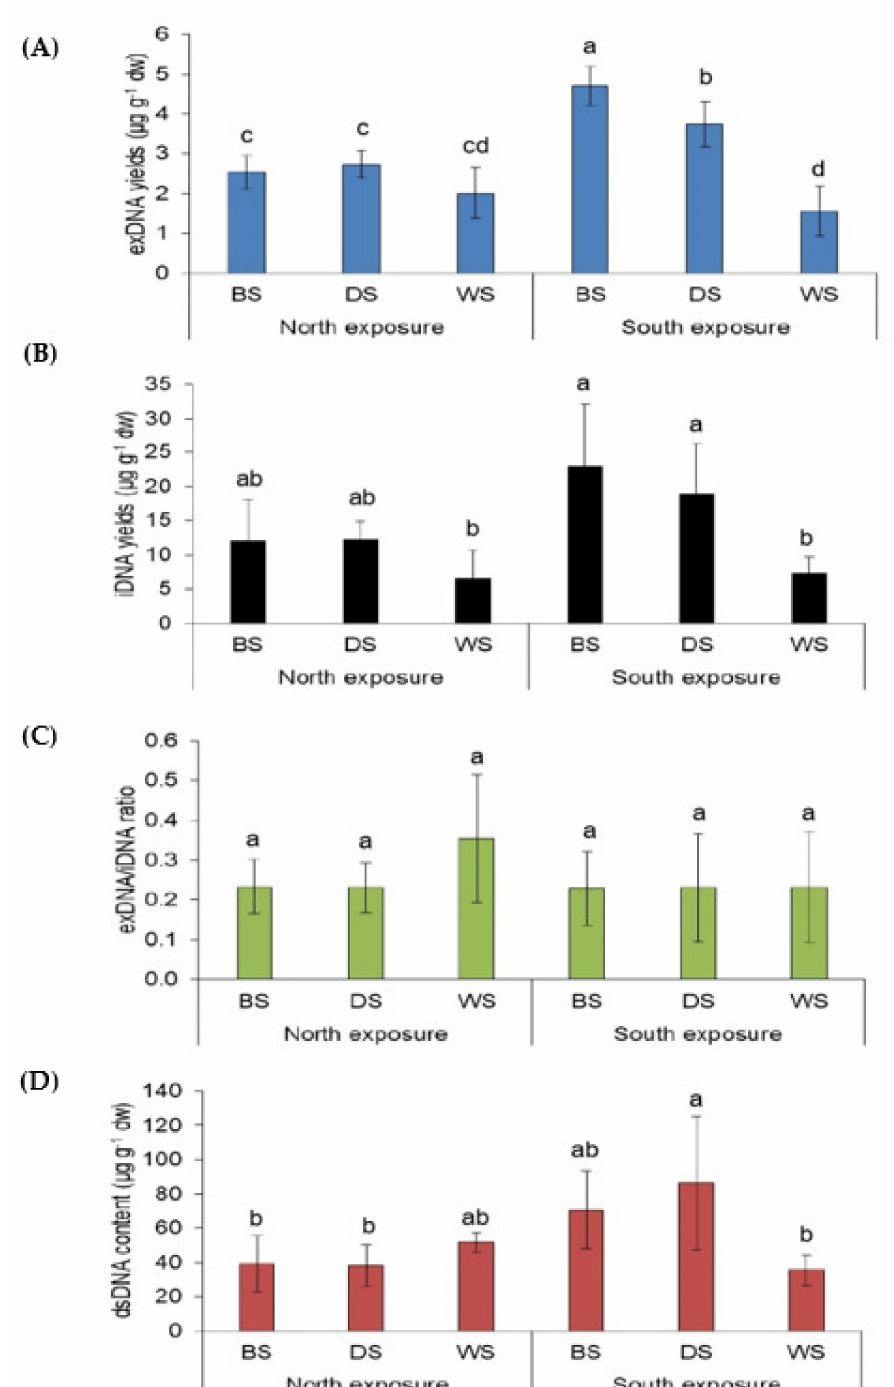
Figure 3. Yields of sequentially extracted extracellular DNA (exDNA; ( A )), intracellular DNA (iDNA; ( B )), and exDNA/iDNA ratio ( C ), and directly extracted double-stranded total DNA (dsDNA; ( D )) in the bulk soil and the aggregate size fractions in the mineral (AE) horizon at the north- and the south- facing sites. Different letters indicate significant differences ( p < 0.05; ANOVA followed by Duncan post-hoc test) regarding the bulk soil (BS), and the dry-sieved (DS) and wet-sieved water-stable (WS) 1.00–0.50 mm